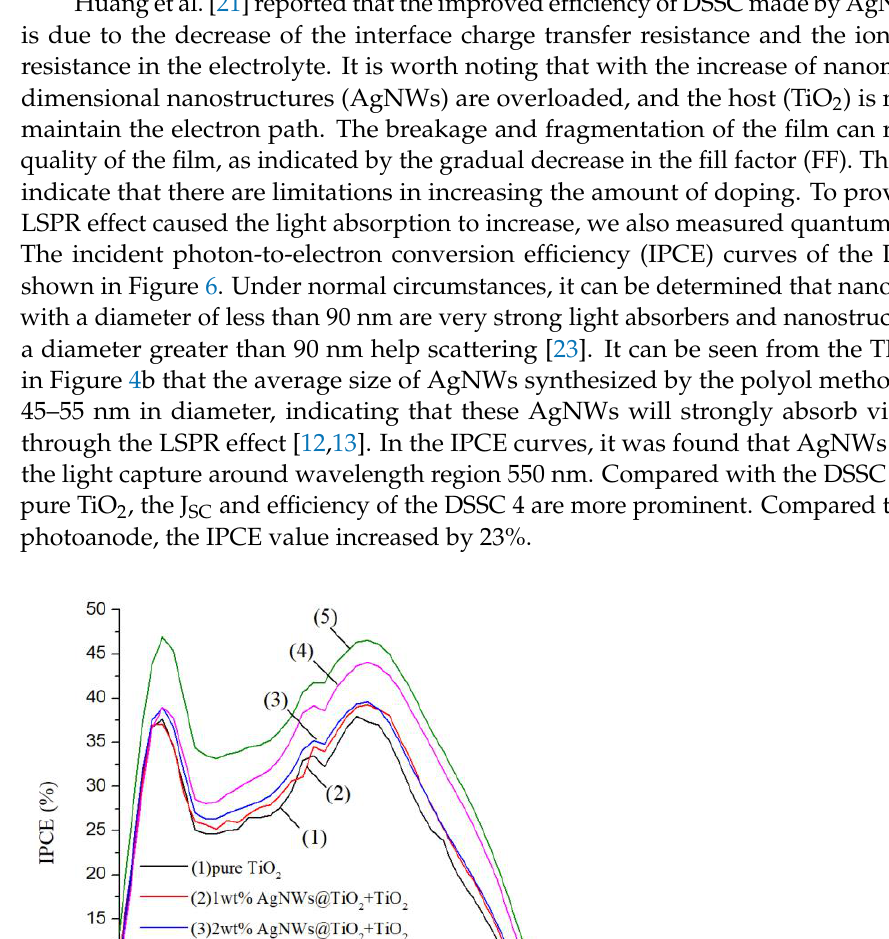
Figure 5. J-V characteristics of different photoanodes.